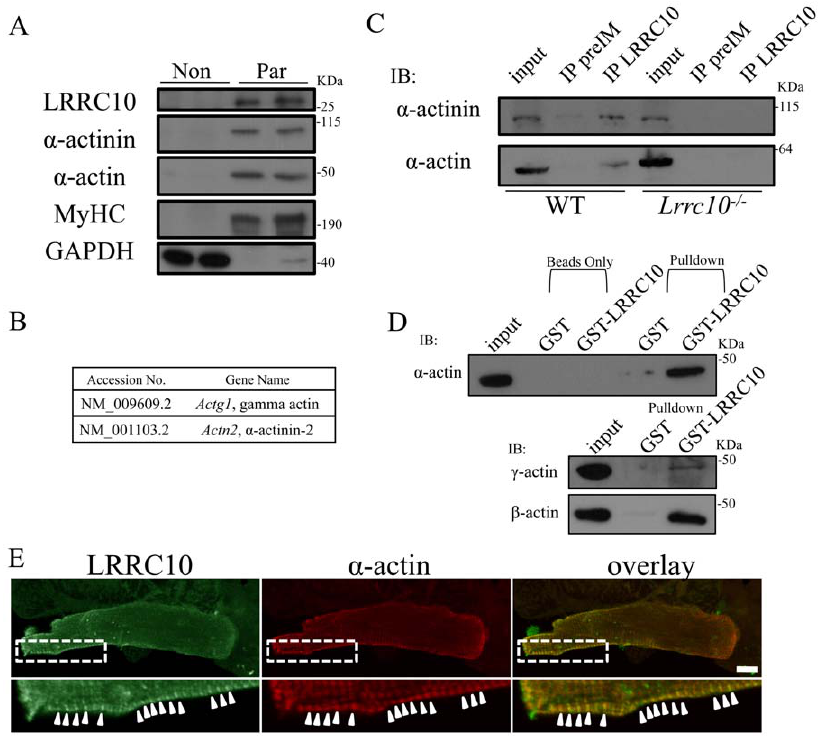
Figure 3. LRRC10 interacts with actin and a -actinin. (A) LRRC10 cofractionates with a -actin and a -actinin in the particulate fraction. Heart extracts from 10-week-old mice were fractionated into a nonparticulate fraction (Non) and a particulate fraction (Par) enriched in myofibril proteins. GAPDH and myosin heavy chain (MyHC) were used as nonparticulate and particulate controls, respectively. (B) Yeast-two hybrid screening identified a -actinin and c -actin as binding partners of LRRC10. (C) a -actinin and a -actin endogenously interact with LRRC10 in the heart. WT or Lrrc10 2 / 2 mouse heart extracts were immunoprecipitated (IP) with preimmune serum (PreIM) or an LRRC10 antibody and immunblotted for a -actinin or a -actin. (D) LRRC10 interacts with a -, b -, and c -actin in vitro. Purified a -actin or cytoskeletal actin was incubated with GST or a GST-LRRC10 fusion protein and pulled down proteins were immunoblotted for a -actin, c -actin, or b -actin. (E) LRRC10 colocalizes with a -actin. Coimmunostaining for LRRC10 and a - actin in adult mouse ventricular cardiomyocytes. Enlargement of boxed area is shown at bottom . Scale bar =10 m m.